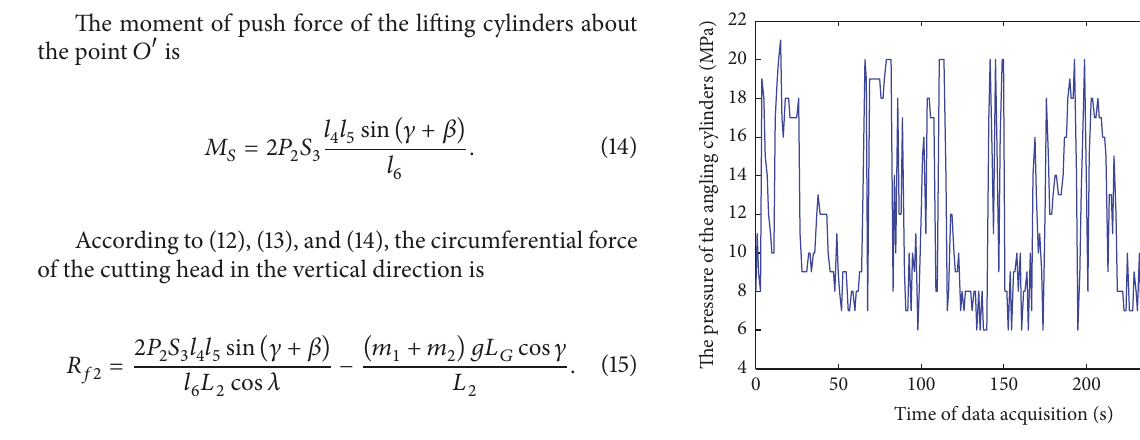
Figure 5: The pressure of the angling